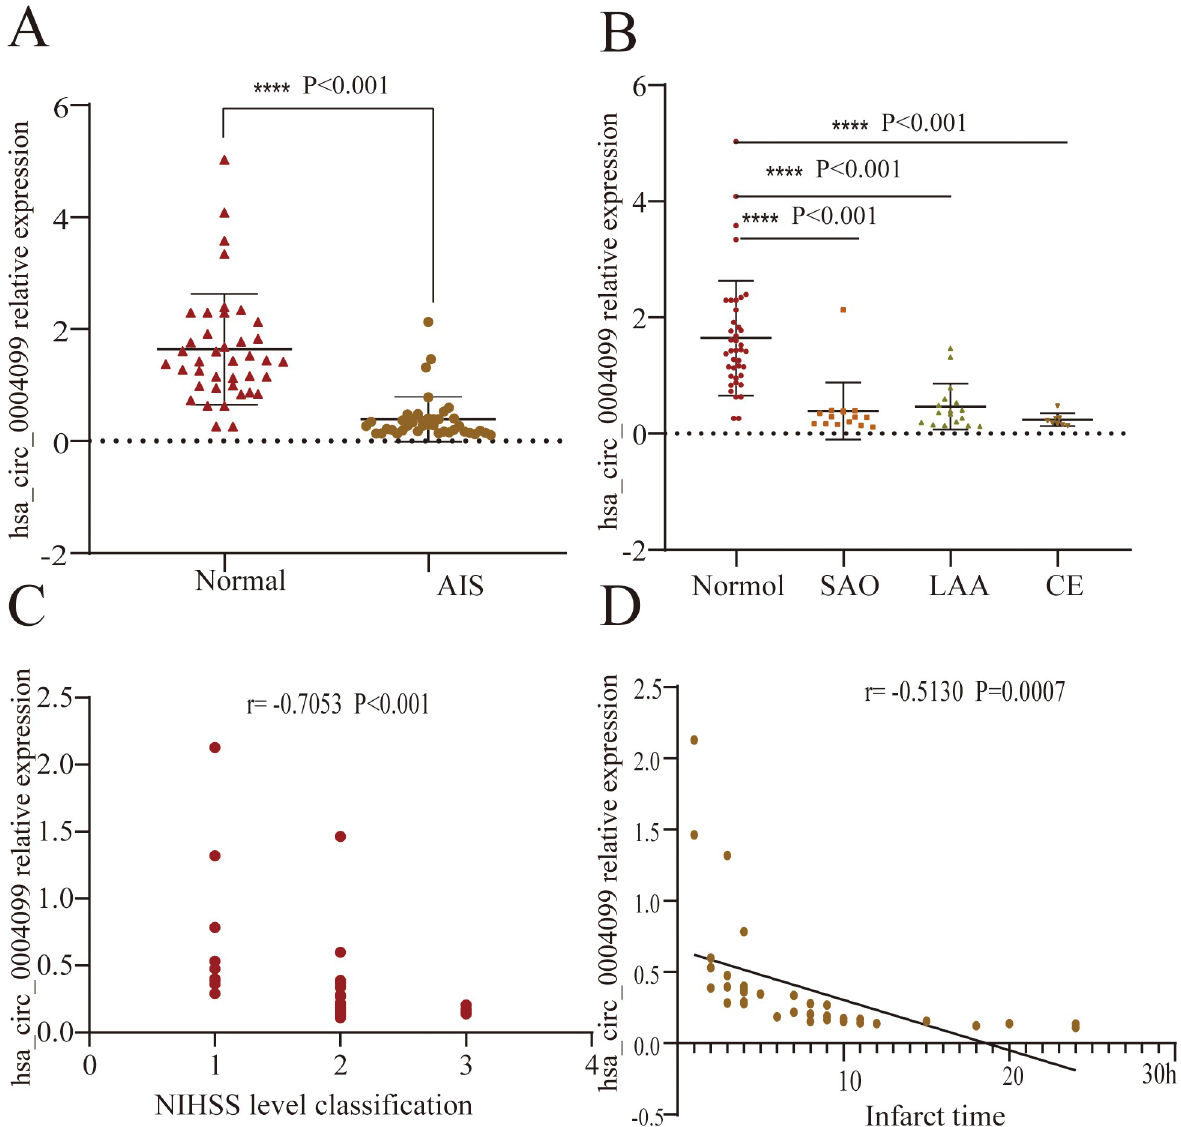
Fig 2. Expression levels of hsa_circ_0004099 in healthy subjects and patients with AIS. A: The Mann-Whitney U -test was used for two-sample comparisons. The expression level of hsa_circ_0004099 was lower in patients with AIS compared with that in healthy subjects. B: The Steel-Dwass test was used for pairwise comparisons. The levels of hsa_circ_0004099 in patients with small-artery occlusion (SAO), large-artery arteriosclerosis (LAA), and cardiac-origin cardioembolism (CE) were different compared to those of normal individuals (P < 0.001). C: Comparison of National Institutes of Health Stroke Scale (NIHSS) disease severity scores and hsa_circ_0004099 levels using Spearman rank correlation: 1 on the abscissa represents "mild,” 2 represents "moderate,” and 3 represents "severe." The expression level of hsa_circ_0004099 showed a downward trend and was highly negatively correlated with the NIHSS scores (P < 0.001, r = -0.7053). D: Pearson correlation analysis was used to compare the infarct time with the hsa_circ_0004099 levels: 1 grid on the abscissa represents 1 hour, and each circle represents a patient with AIS (40 patients in total). As shown in the figure, with the prolongation of infarction time, the expression of hsa_circ_0004099 showed a downward trend. The levels of hsa_circ_0004099 were negatively correlated with the infarct time (P < 0.001, r = -5130).